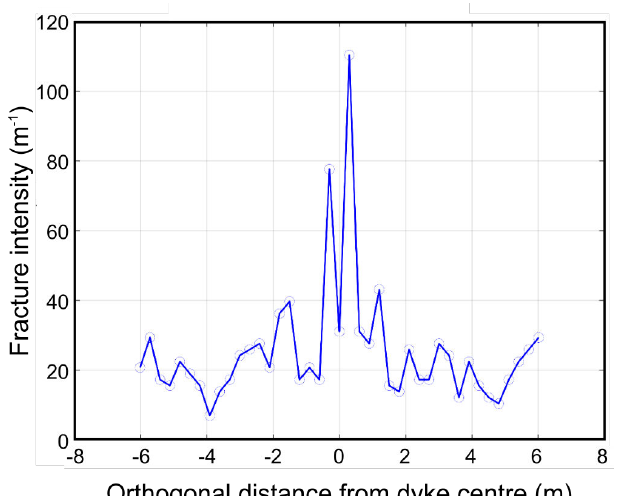
Figure 11: Example of estimated fracture intensities around a dyke segment. Estimated fracture intensity (number of fractures/metre) has been plotted against orthogonal distance from the centre of one segment of Dyke 1. At this locality, this segment of Dyke 1 is ap- proximately 50 cm thick. Away from the dyke, esti- mated fracture intensity varies from about 10 m − 1 to about 30 m − 1 . Within one dyke width (i.e. 0.5 m), the estimated fracture intensity jumps to > 100 m − 1